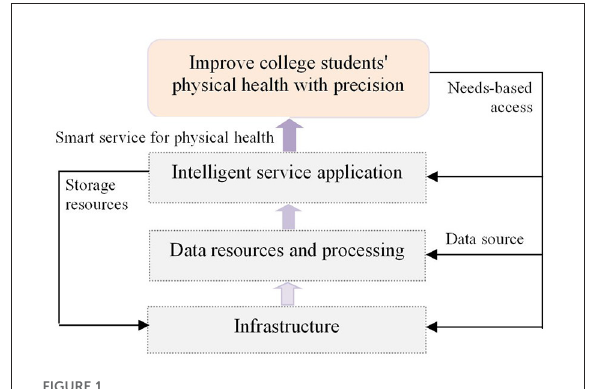
FIGURE1 Data-driven intelligent governance system architecture of college students’ physical